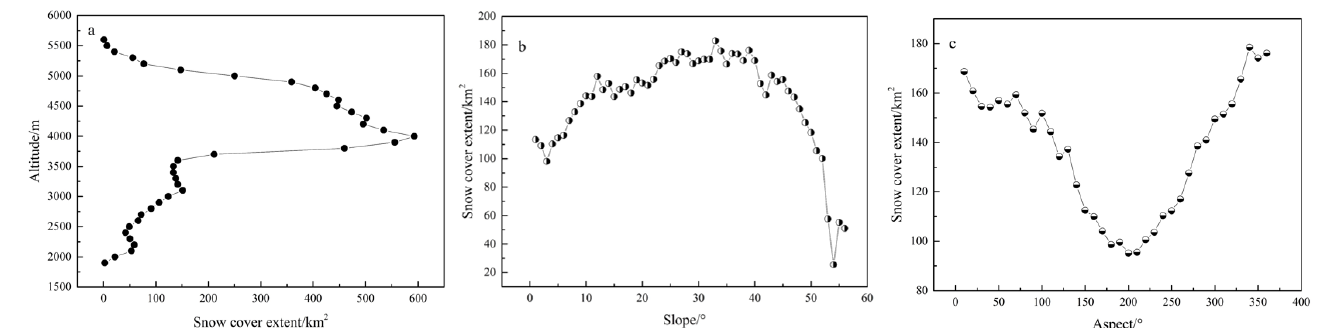
Figure 7. Correlation between snow cover and DEM, slope, and aspect in the upper reaches of the Shule River.